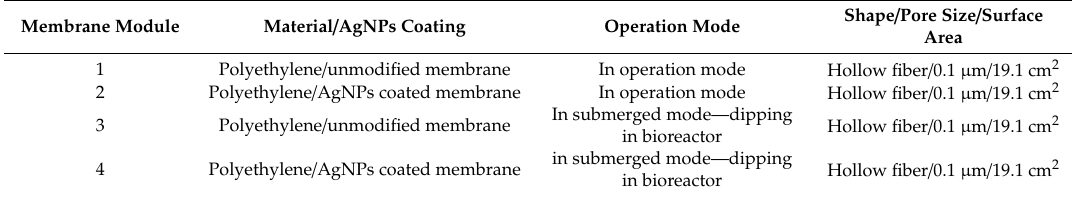
Figure 9. Schematic of the experimental setup for lab-scale MF-MBR system. Table 3. MF membrane modules used in the